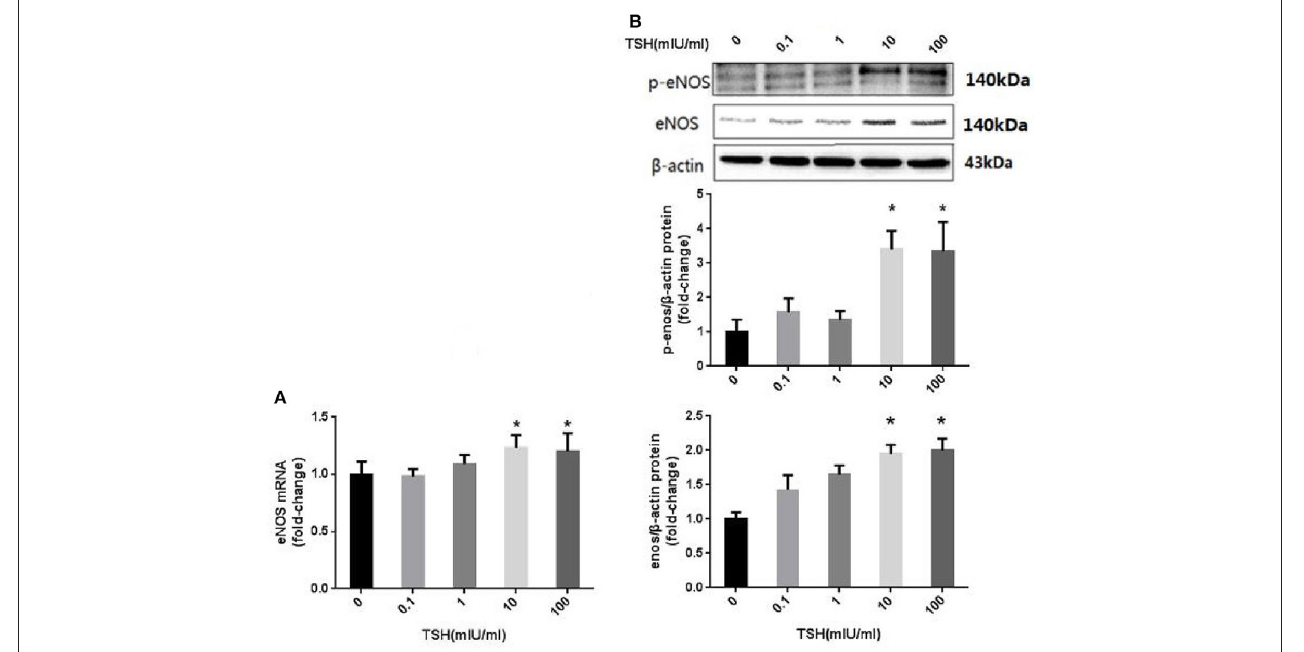
FIGURE 3 | eNOS expression and its phosphorylation in HUVECs stimulated by different concentrations of TSH. (A) mRNA expression of eNOS in HUVECs stimulated by different concentrations of TSH (0, 0.1, 1, 10, and 100 mIU/ml); (B) Protein expression of eNOS in HUVECs treated with different concentrations of TSH. Data were obtained from three separate experiments. HUVECs without stimulating with TSH (0 mIU/ml) served as control; * P < 0.05, when compared with the control.